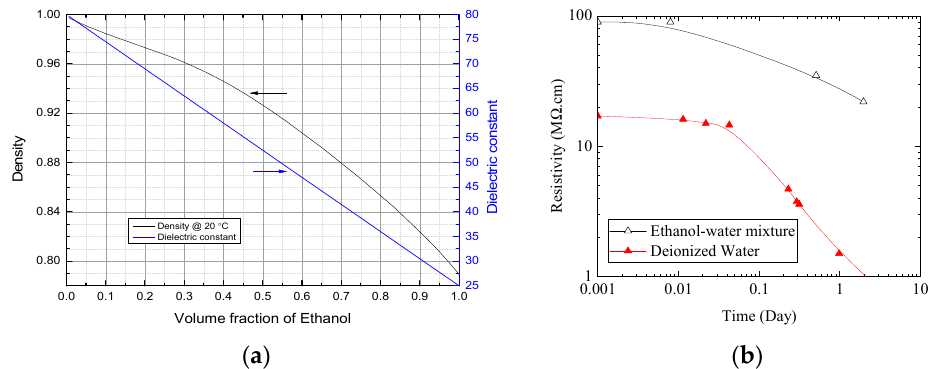
Figure 3. ( a ) Relation between the density, relative dielectric constant of ethanol–water mixture, and the volume fraction of ethanol; ( b ) The mixture has a higher resistivity than deionized water and its decay with time is also slower.